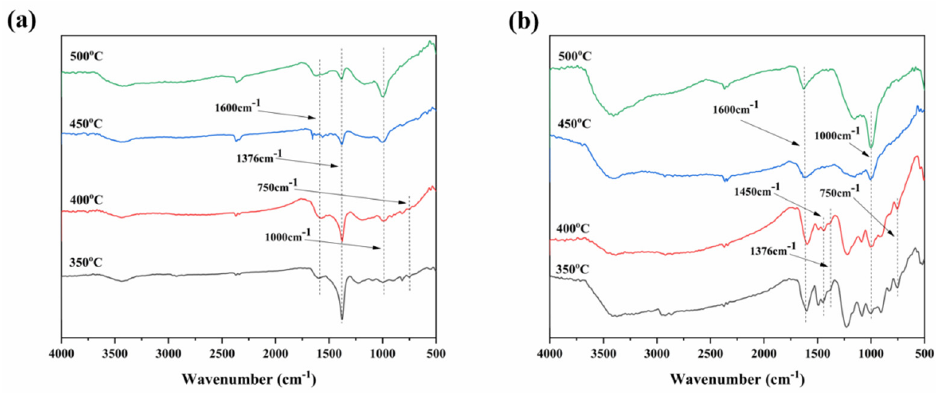
Figure 11. FTIR spectra of the char residues of EP/15RGO@APP ( a ) and EP/15RGO-APP ( b ) heated at different temperatures in a muffle furnace.